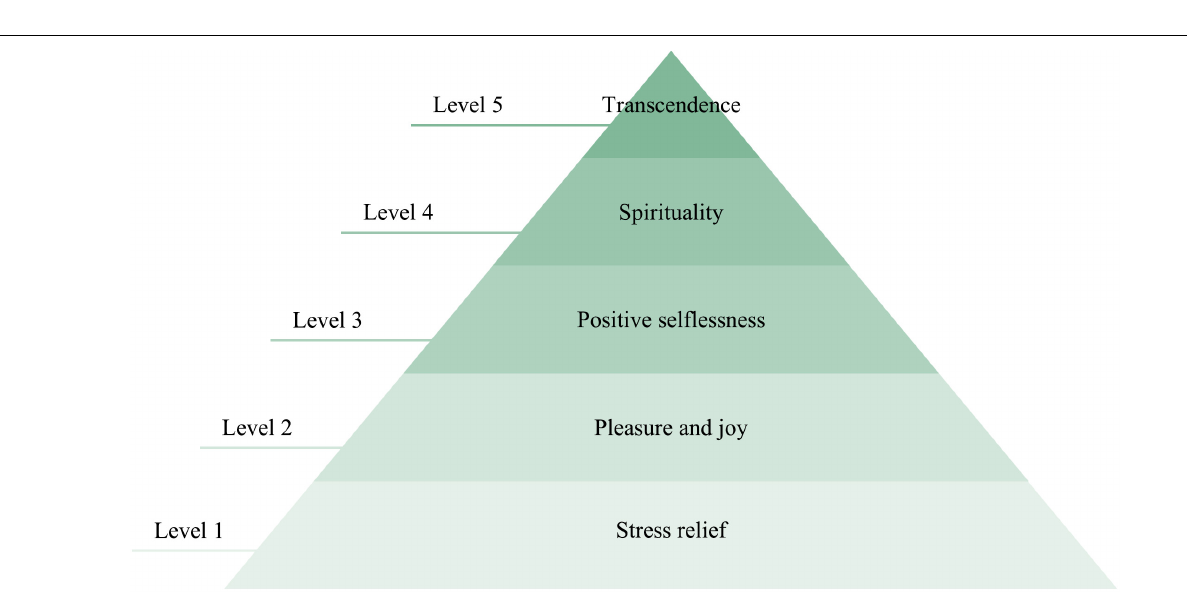
FIGURE 1 | Design process of virtual reality relaxation scenes.